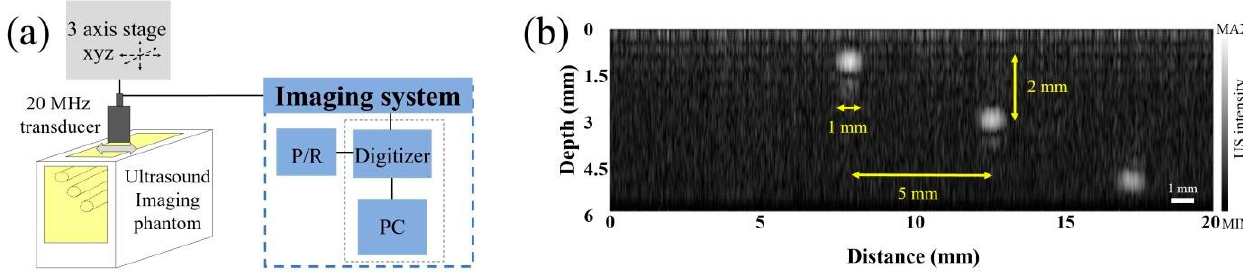
Figure 6. Phantom imaging for an evaluation imaging system using the 20.0 MHz transducer. ( a ) Schematic diagram of the ultrasound imaging system and ( b ) a phantom image with monofilament line targets with a diameter of 1 mm in the tissue-mimicking structure.